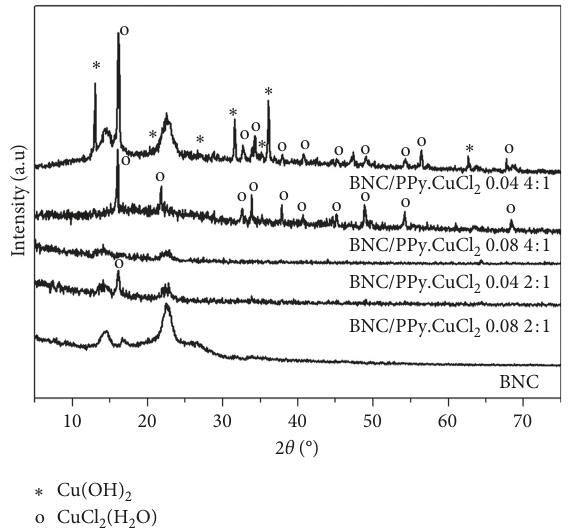
Figure 3: XRD patterns of BNC/PPy